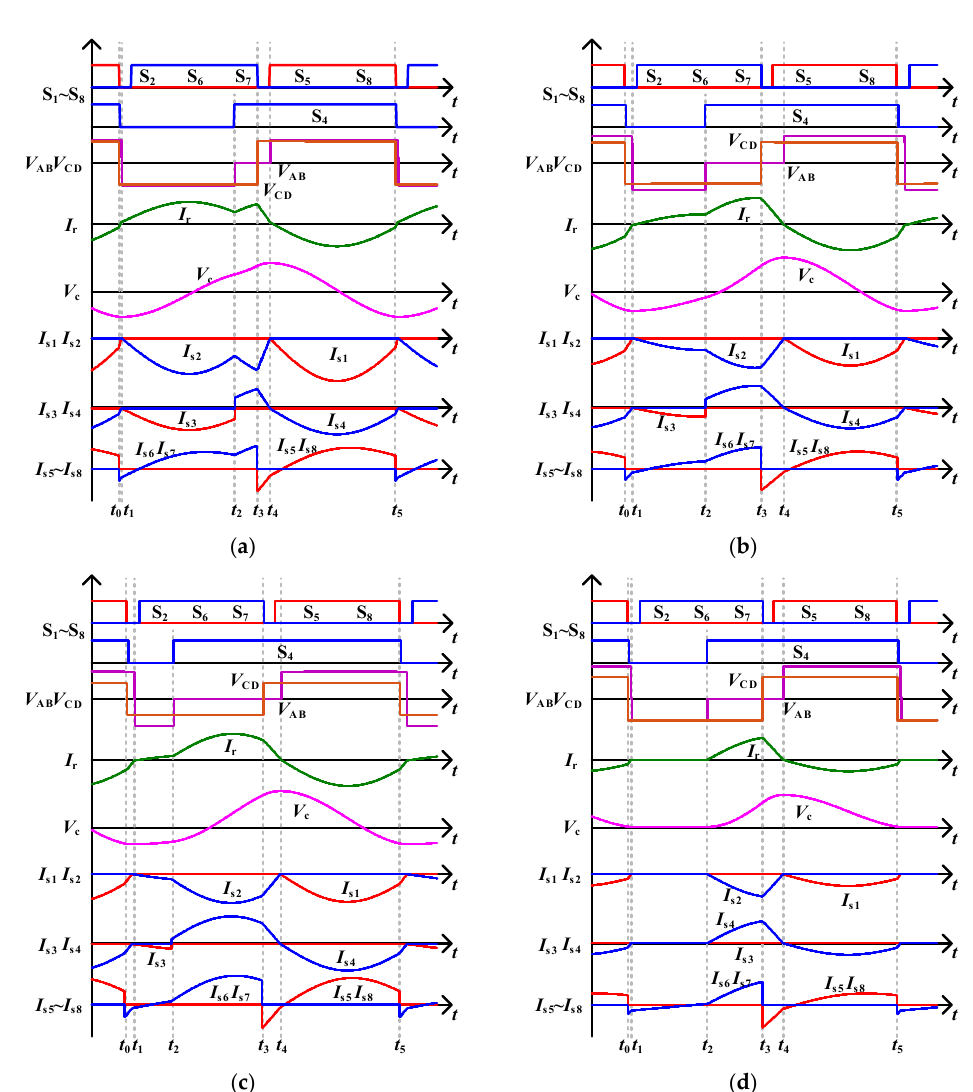
Figure 2. Typical waveforms of the step-up control strategy under the backward mode. ( a ) d = 62.5%, ( b ) d = 75%, ( c ) d = 87.5%, ( d ) light load. In Figure 2, V AB and V CD represent the voltages between A and B, and C and D, respectively, in Figure 1; I s1 – I s8 represents the forward current passing through S 1 –S 8 ; and the equivalent circuit change moments are defined as t 0 – t 5 .